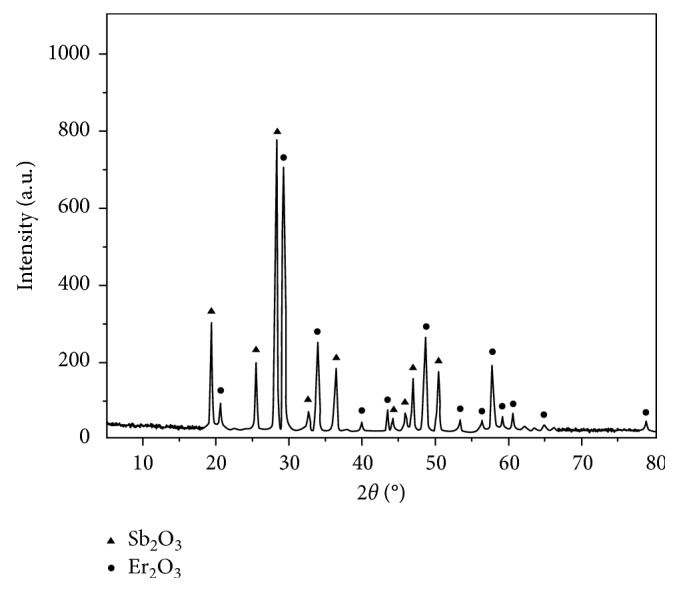
XRD pattern of the pyrolysis residue.